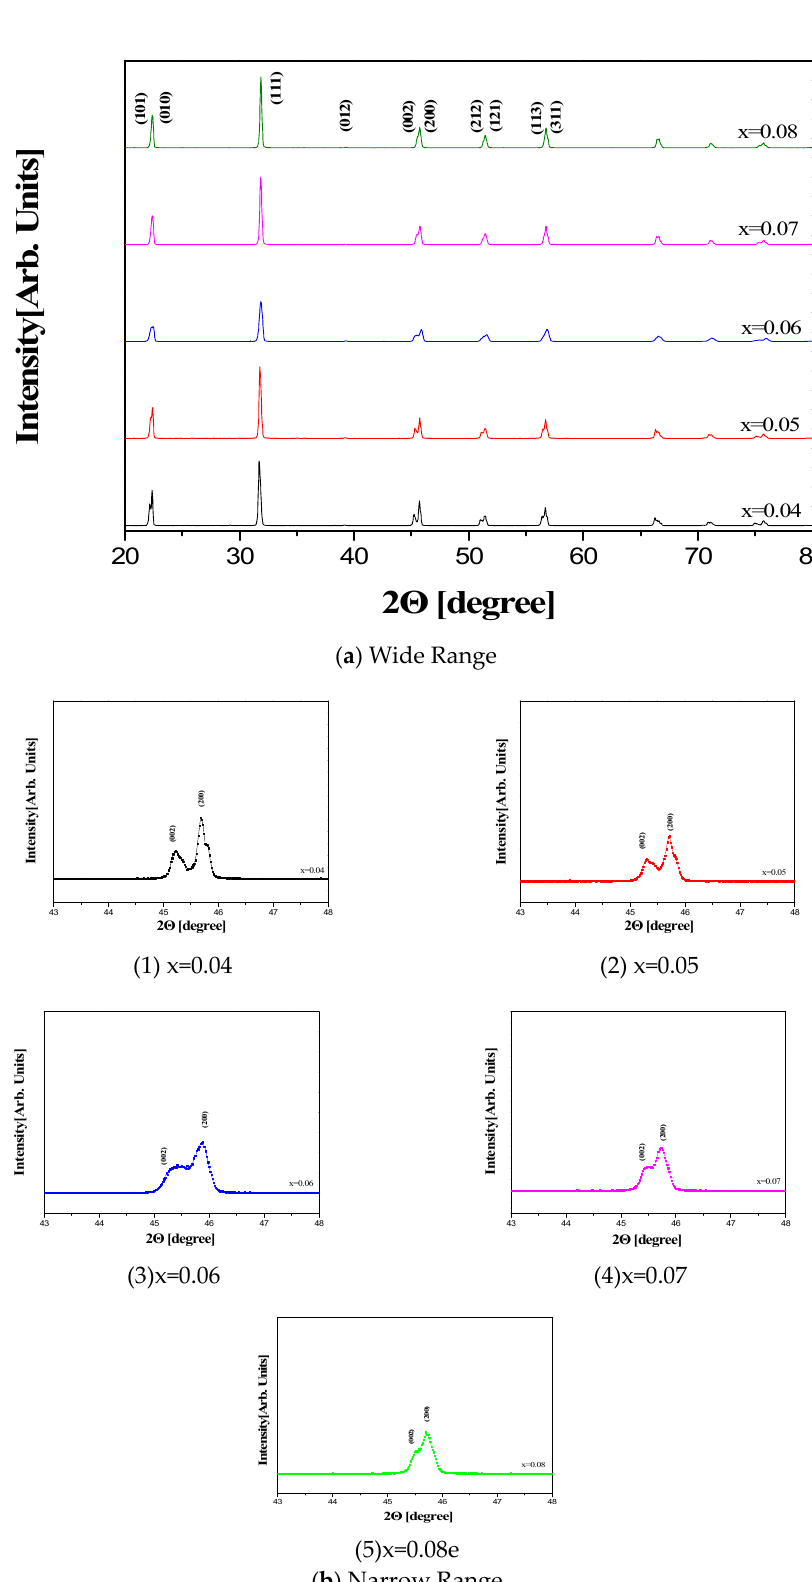
Figure 2. Grain size of samples with the amount of antimony.